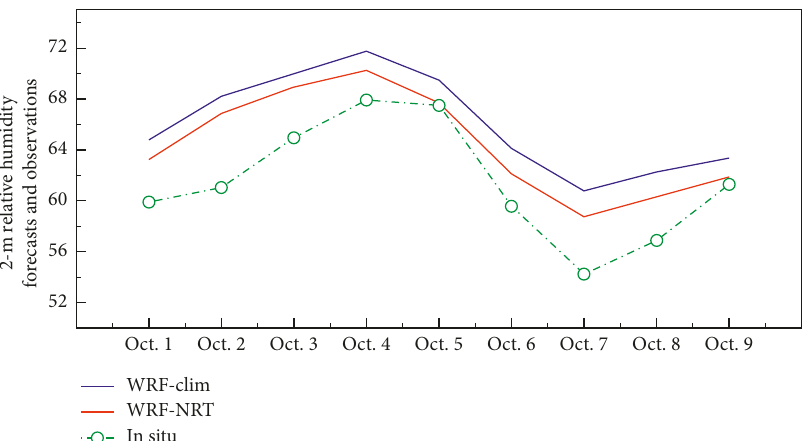
Figure 9: Comparison of 2m relative humidity (RH2m) forecasts between WRF runs (with climatology and NRT GVF) and in situ observations; RH2m averaged from all validation sites over CONUS.